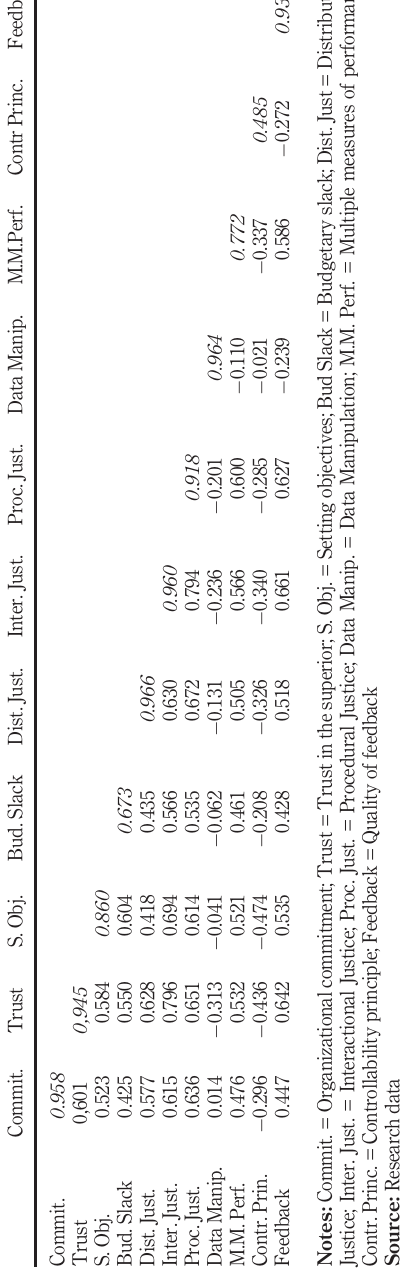
Table V. Discriminant